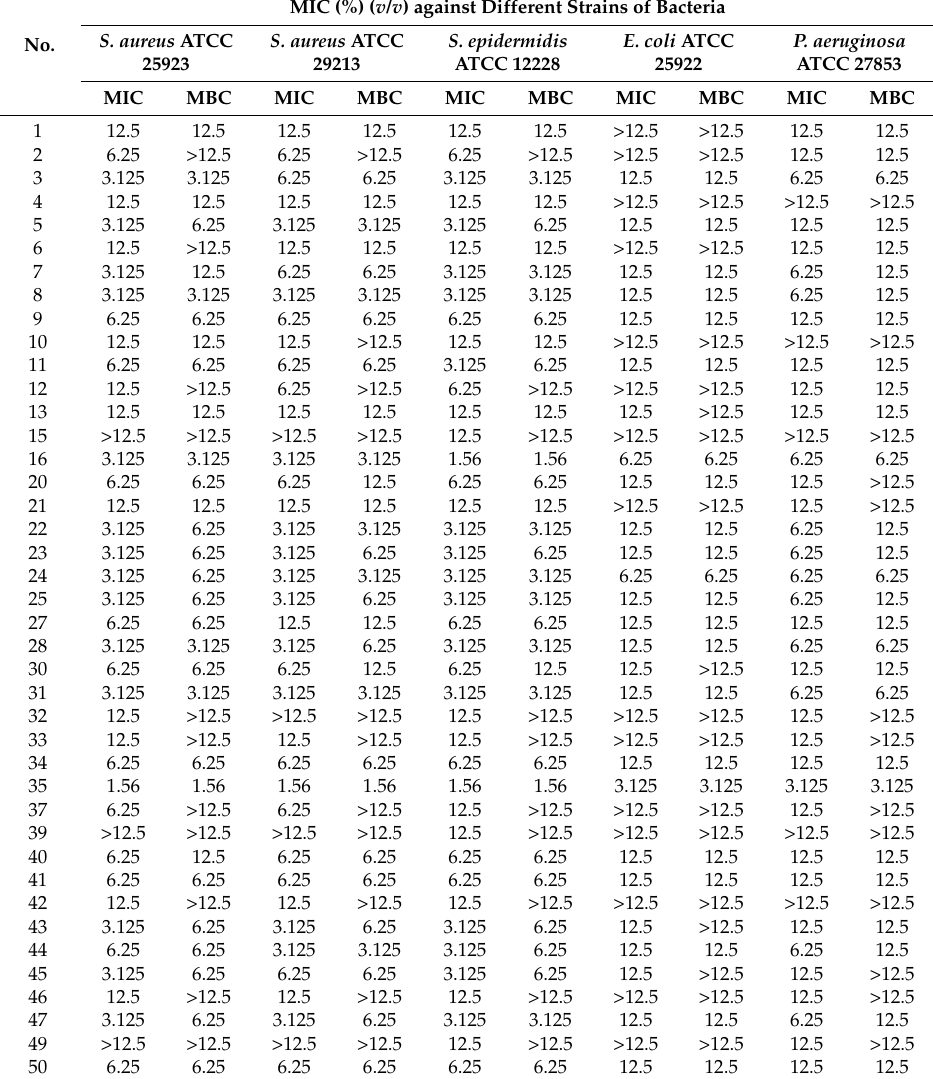
Table 1. Antibacterial activity of Polish honeys against different reference strains of bacteria 1 .